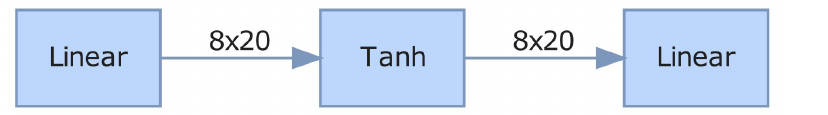
Figure 3. The network structure of the first autoencoder of the DAE-based filter.